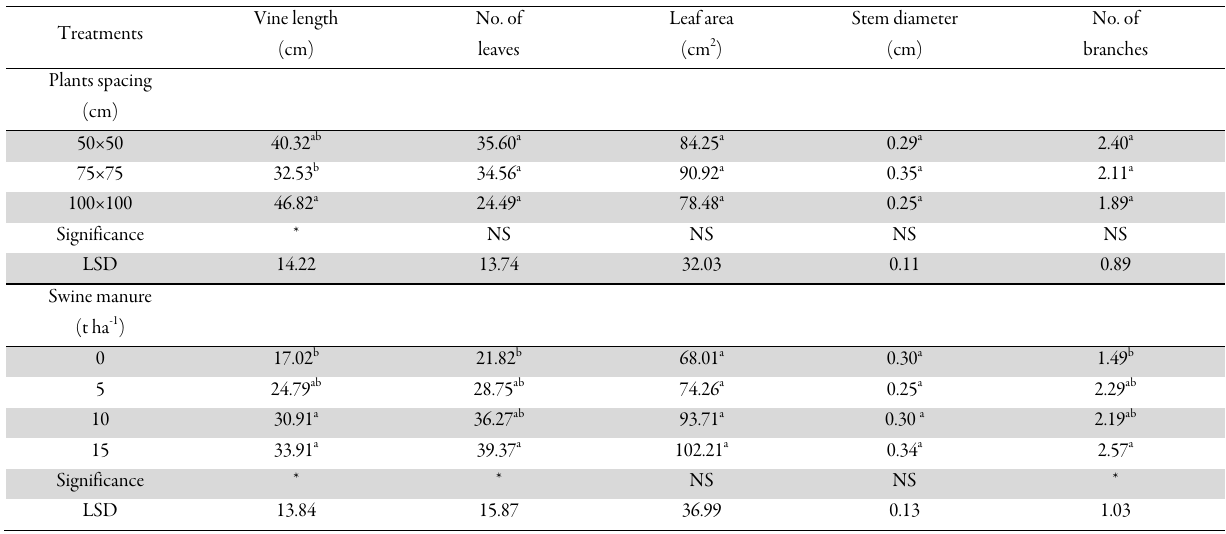
Table 2. Effect of spacing and swine manure on some vegetative parameters of muskmelon ( Cucumis melo L.)